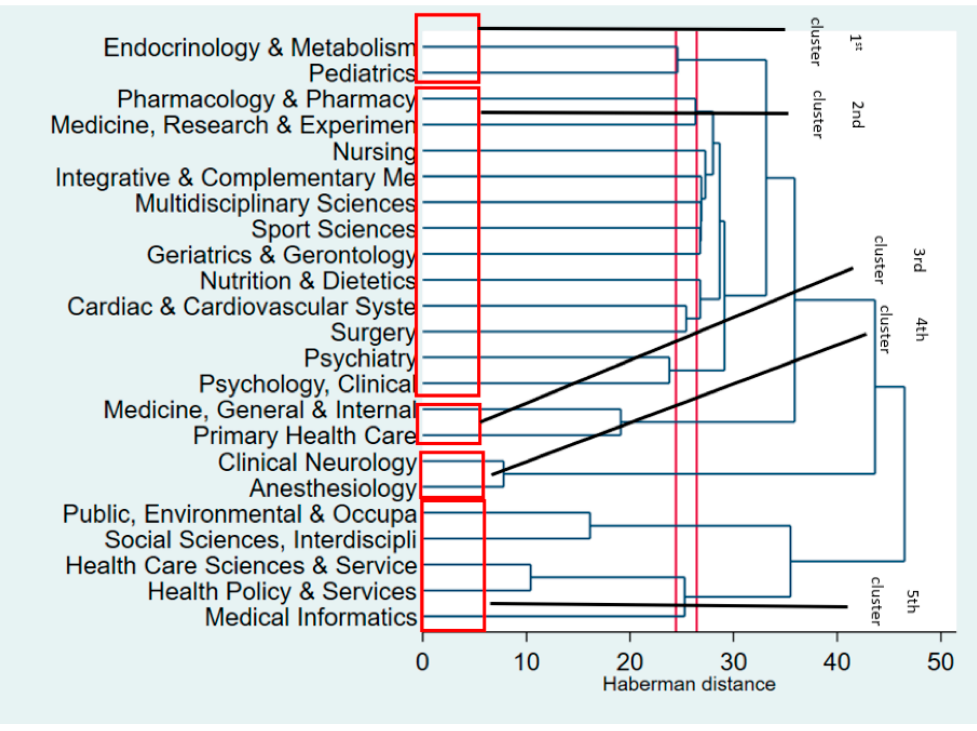
Figure 4. Dendrogram of coincidence of research areas using WOS classifications.